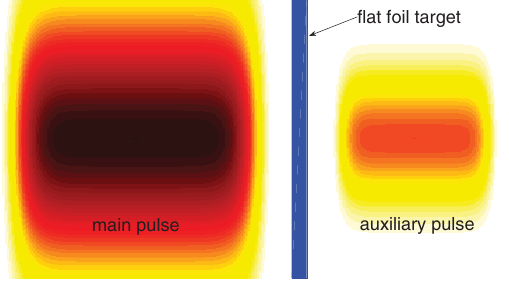
FIG. 1. Schematic diagram of our scheme that two matched counterpropagating transversely Gaussian lasers impinge on a flat foil